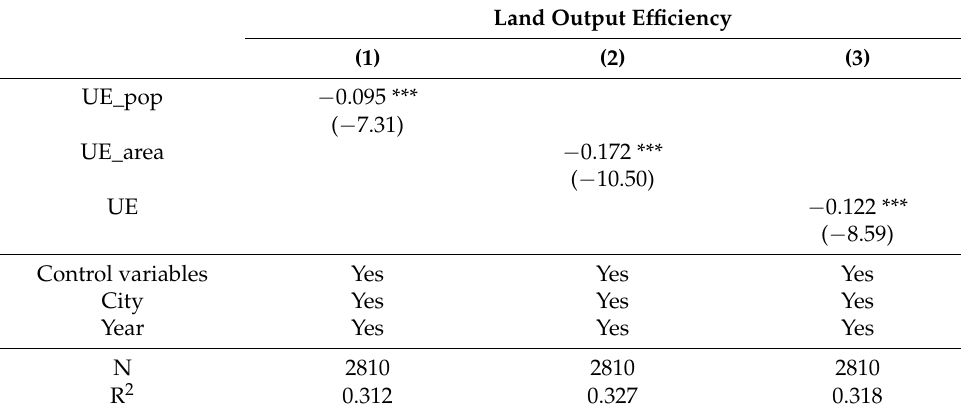
Table 8. Regression results of land output efficiency.